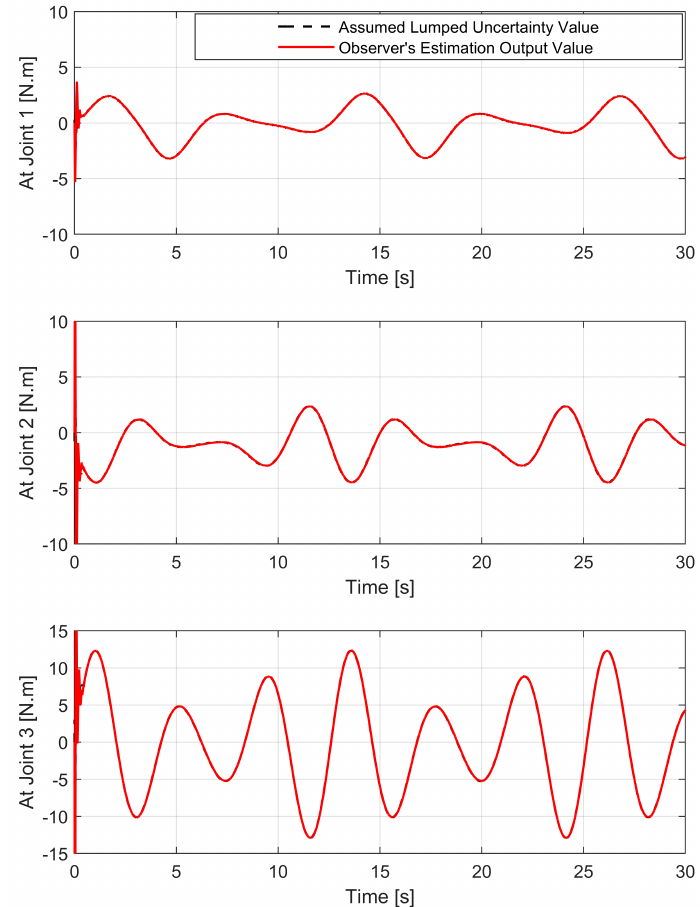
Figure 4. Estimation performance the proposed USOSMO.